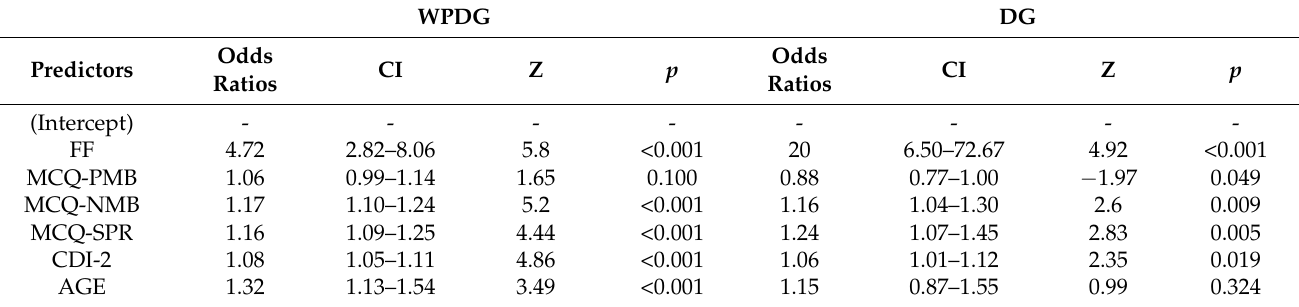
Table 5. Results of the univariate logistic regression analysis on well-being.